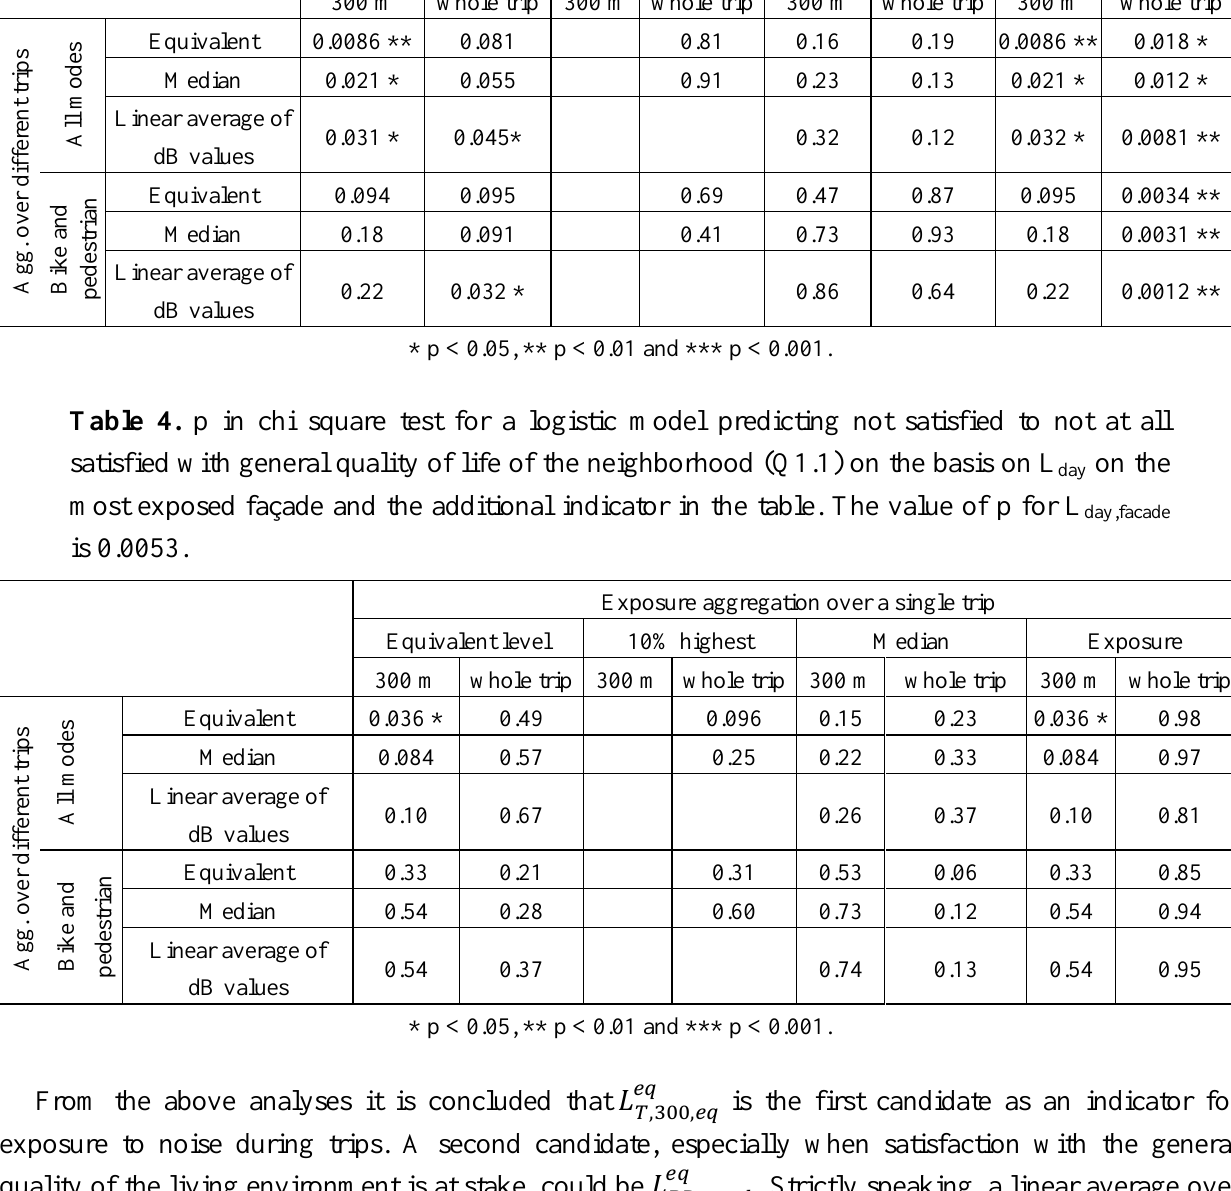
Table 3. p in chi square test for a logistic model predicting satisfied to very satisfied with general quality of life of the neighborhood (Q1.1) on the basis on L façade and the additional indicator in the table. The value of p for L